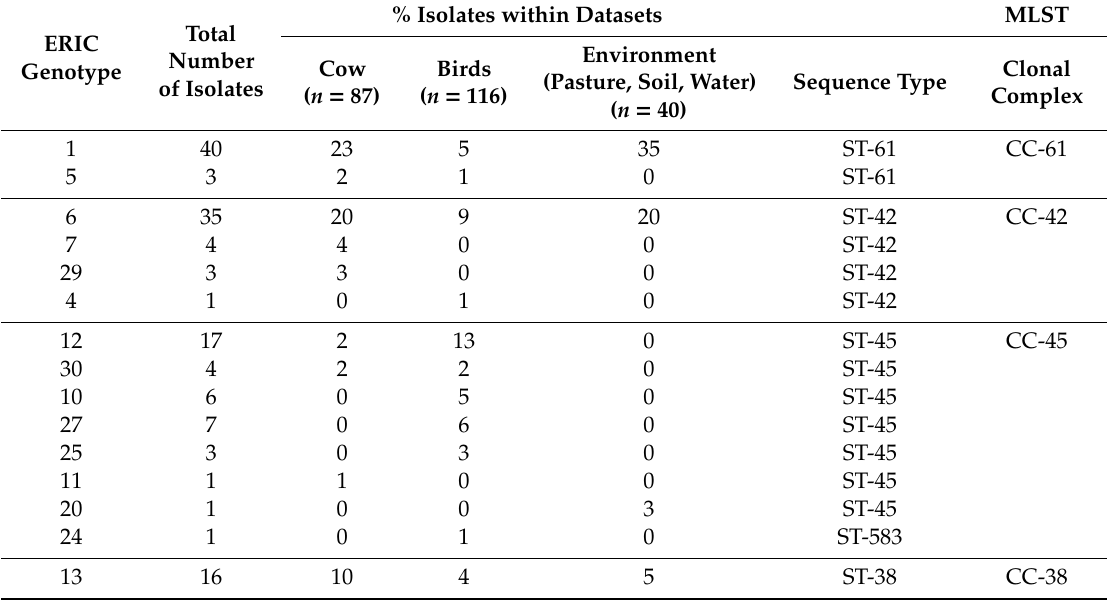
Table 2. Relative distribution of C. jejuni ERIC genotypes within cows, birds, and environmental datasets. The rodent dataset (9 isolates) was not included in the